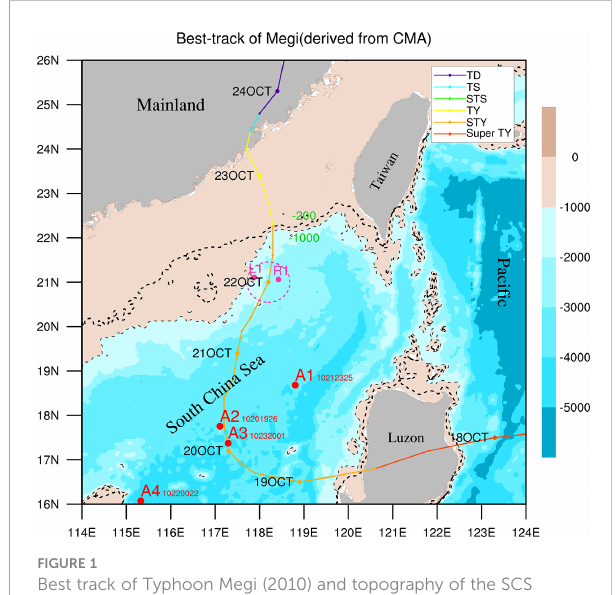
FIGURE 1 Best track of Typhoon Megi (2010) and topography of the SCS (contour, black dashed line: − 200 m and − 1,000 m). Different colors of the curve and points stand for different intensities according to the Chinese National Standard for Grade of Tropical Cyclones. Magenta dots represent the positions of moorings (L1: 117°52.66 ’ E, 21°06.57 ’ N; R1: 118°25.61 ’ E, 21°03.59 ’ N), and red dots represent the positions of recorded Argo fl oats (A1: 118.8030°E, 18.6820°N; A2: 117.1080°E, 17.7550°N; A3: 117.2930°E, 17.3730°N; A4: 115.3280°E, 16.0760°N). The double maximum wind radius of Megi at 00 UTC on 22 October is indicated by the dashed magenta